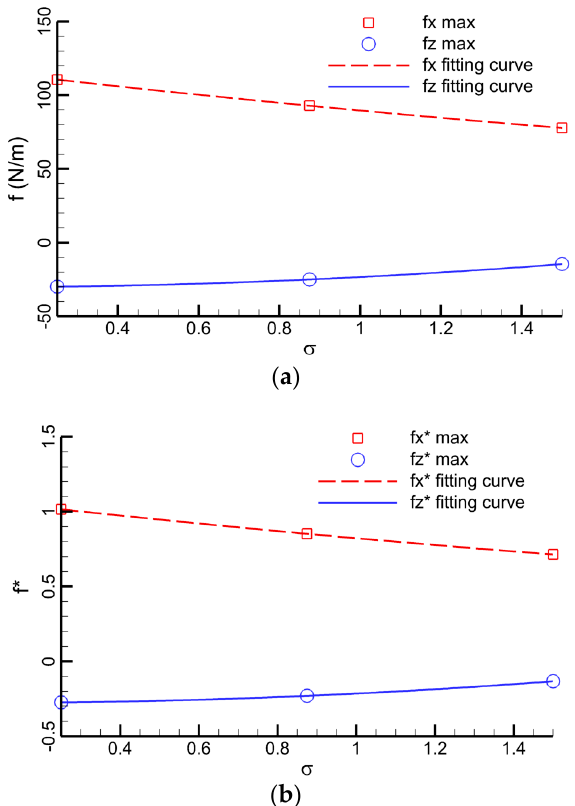
Figure 28. The hydrodynamic forces on pipeline with different scour depths. ( a ) Maximum force. ( b ) Non-dimensional maximum force.